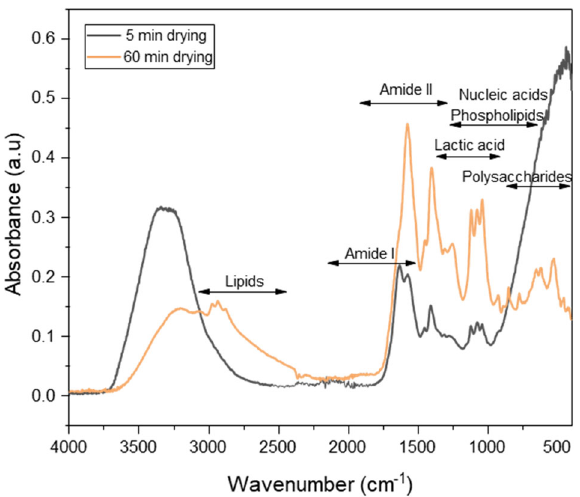
Fig. 2 IR-ATR spectra of L. parabuchneri planktonic cells recorded during the drying process. IR-ATR spectra were recorded every 5 min until 60 min.